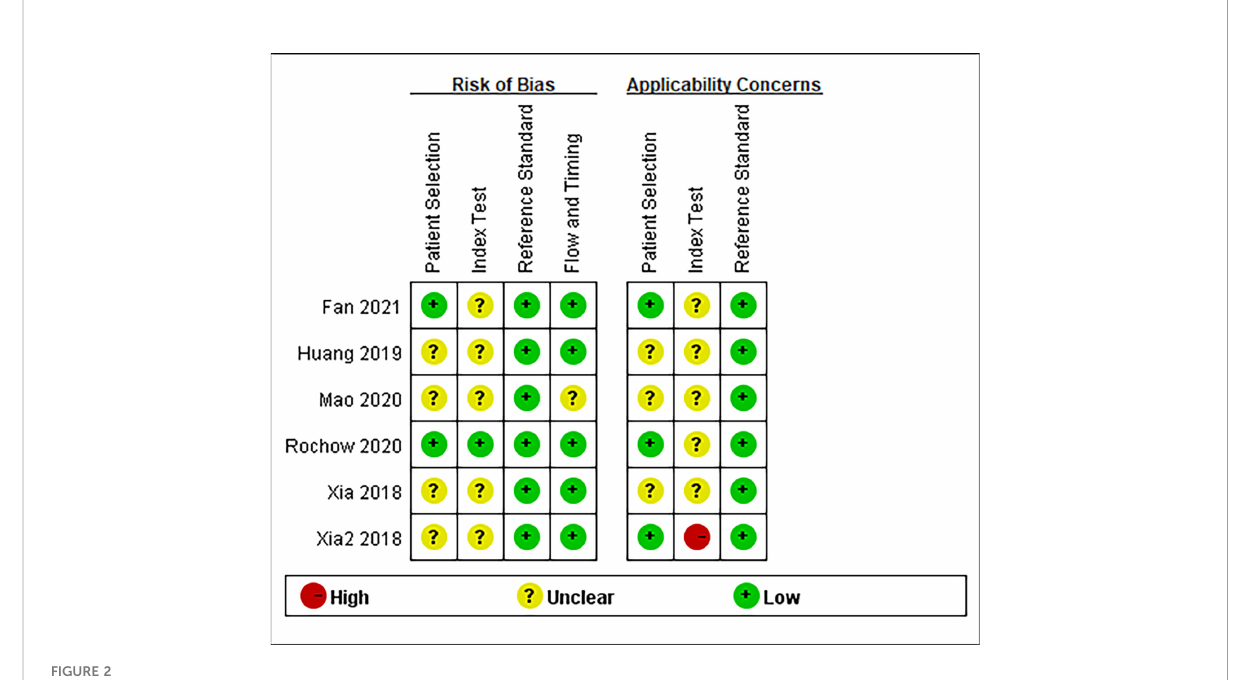
FIGURE 2 Quality assessment of eligible studies for diagnostic meta-analysis.